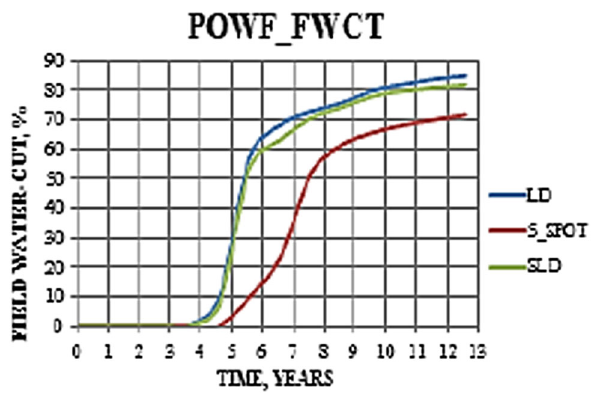
Fig. 19 Plot of field water-cut versus time for different PoWF